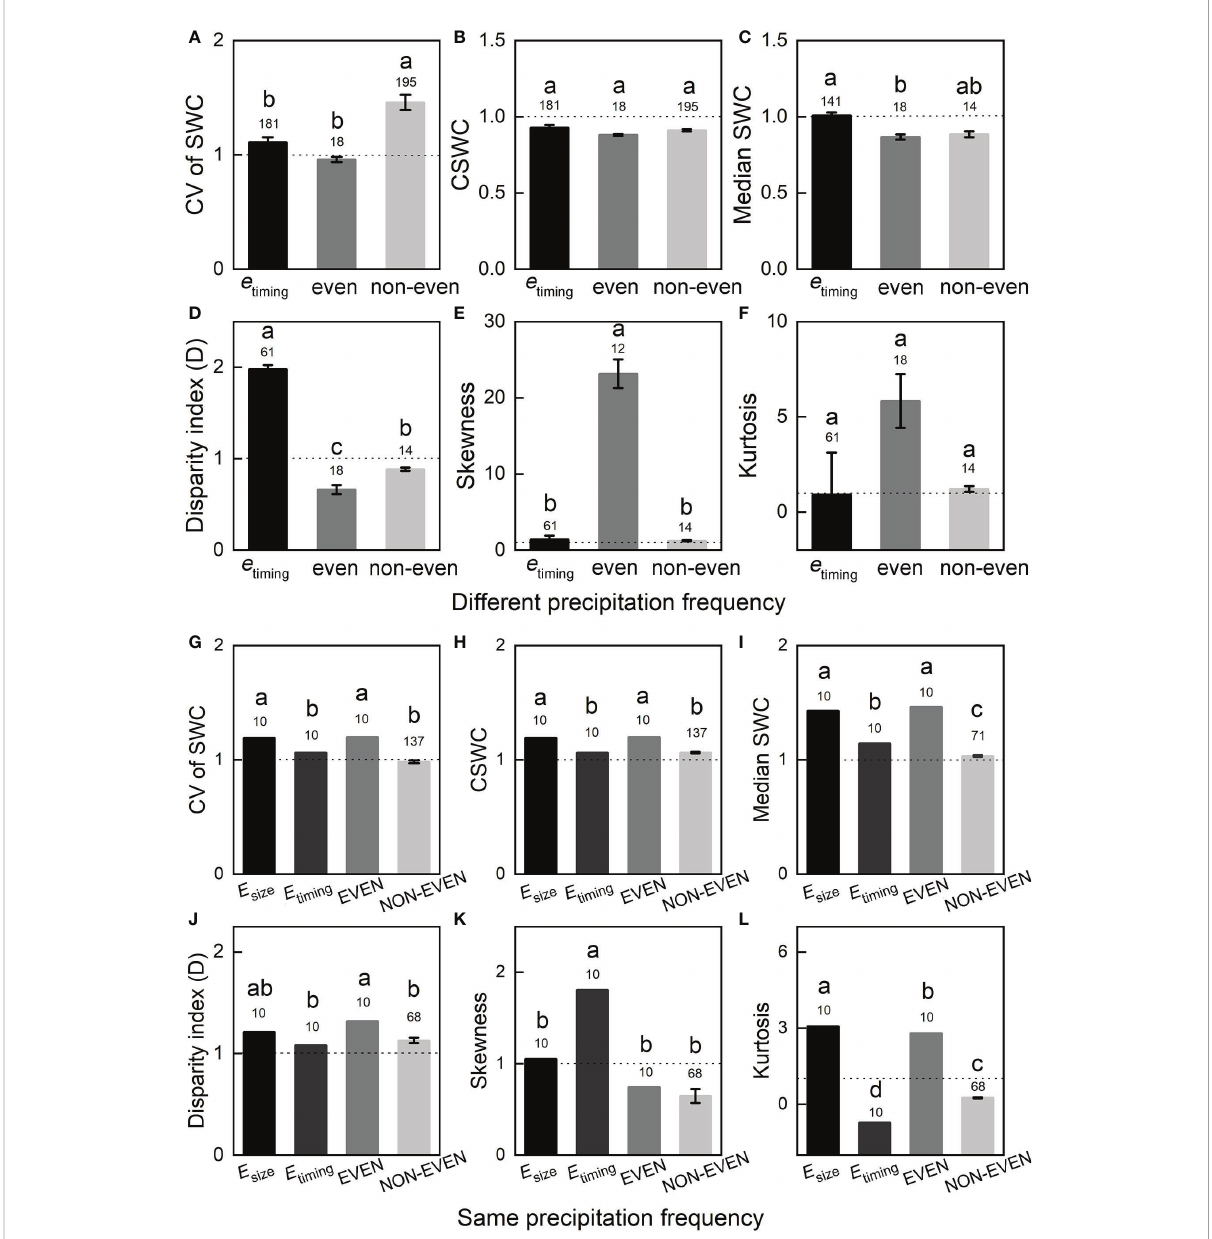
FIGURE 4 The bar chart indicate the treatment effects on multiple indices of soil moisture including (A, G) the coef fi cient of variation (CV) of soil moisture, (B, H) change in soil moisture (CSWC), (C, I) median soil moisture, (D, J) the consecutive disparity index (D) of soil moisture, (E, K) soil moisture skewness, (F, L) soil moisture kurtosis in different precipitation frequency and same precipitation frequency. Data are reported as mean ± SE, and numbers indicate the number of data observations. The dotted lines indicate the reference line for treatment intensity. Signi fi cant differences among treatments ( p < 0.05) are indicated by different letters. See Figure 3 for